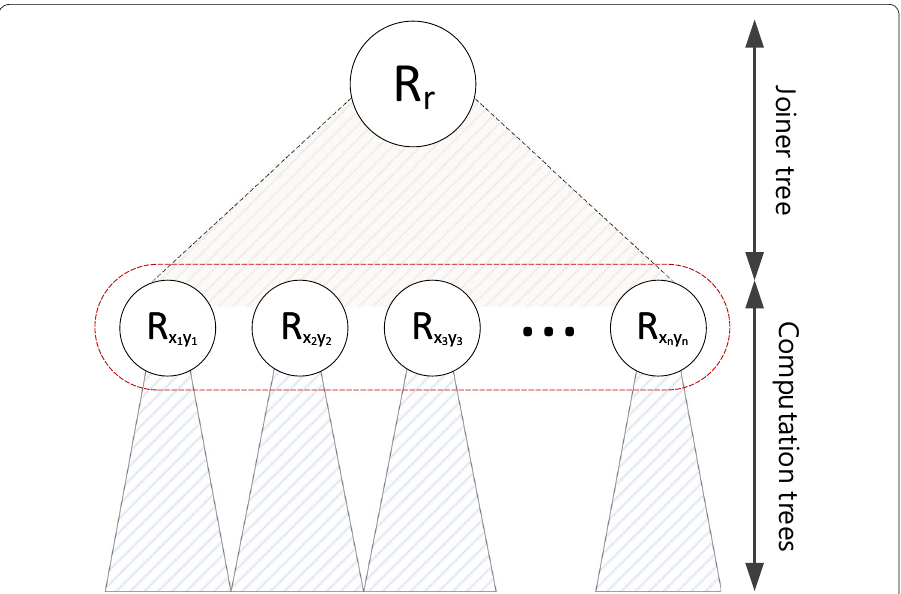
Fig. 5 Schema of a joined